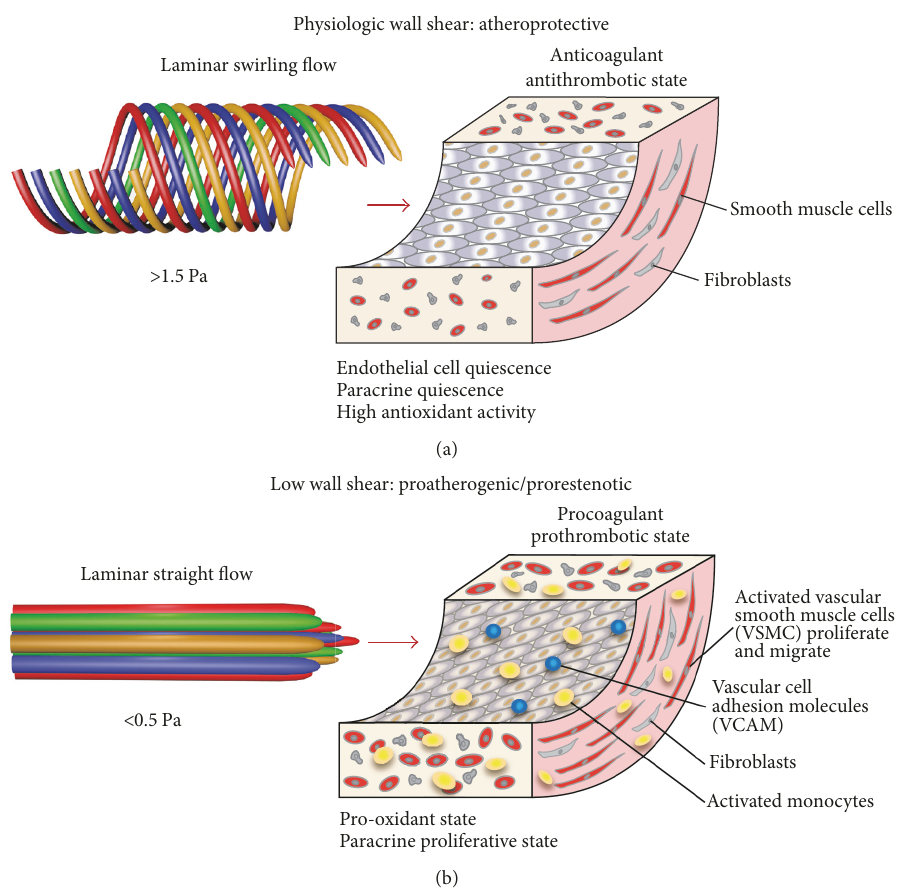
Figure 2: A model of atherogenesis/restenosis, showing differences caused by physiologic arterial wall shear (a) and low (proathero- genic/prorestenotic) wall shear (b) in upregulation of endothelial-cell genes and proteins that are atheroprotective/antirestenotic or atherogenic/restenotic. Adapted from Malek et al. with permission [30].